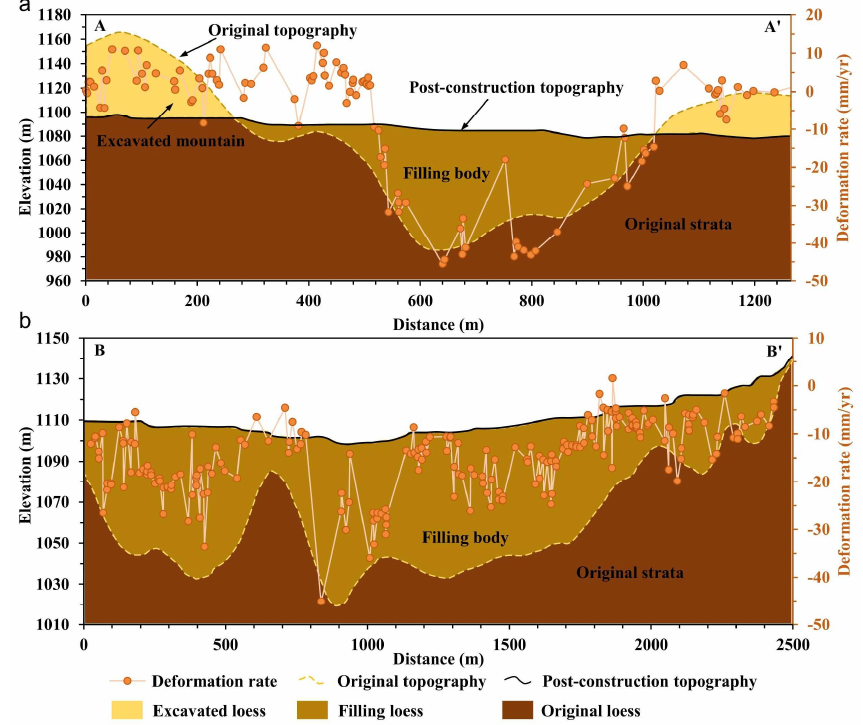
Figure 9. Comparison of the subsidence with the thickness of filling loess along two profiles of which the positions are marked in Figure 8. A negative deformation means subsidence. In order to quantitatively determine the correlation between the fill thickness and the land subsidence, the fill thickness at each CT in the Qiaoergou region was extracted and then statistically analyzed. Figure 10a presents the percentage of CTs with different de- formation rates in different fill thicknesses. Almost all of the ground subsidence (94.7% of the total CTs with deformation rates below −10 mm/year) is concentrated in the area where the thickness of the fill is greater than 30 m. Moreover, as the thickness of the fill increases, the proportion of CTs with higher subsidence rates increases significantly; in particular, subsidence at rates exceeding 50 mm/year was only observed in the area where the thick- ness of the fill is greater than 70 m. In contrast, no subsidence or minor subsidence was observed in areas with low fill thickness, especially below 20 m. Figure 10b presents the average subsidence rate for different fill thicknesses. A positive correlation between the subsidence rate and the fill thickness was observed; that is, the subsidence rate increases significantly with increasing filling loess thicknesses. These phenomena suggest that the different magnitudes of land subsidence after land creation are largely controlled by the compaction process of the filling loess with different thicknesses.